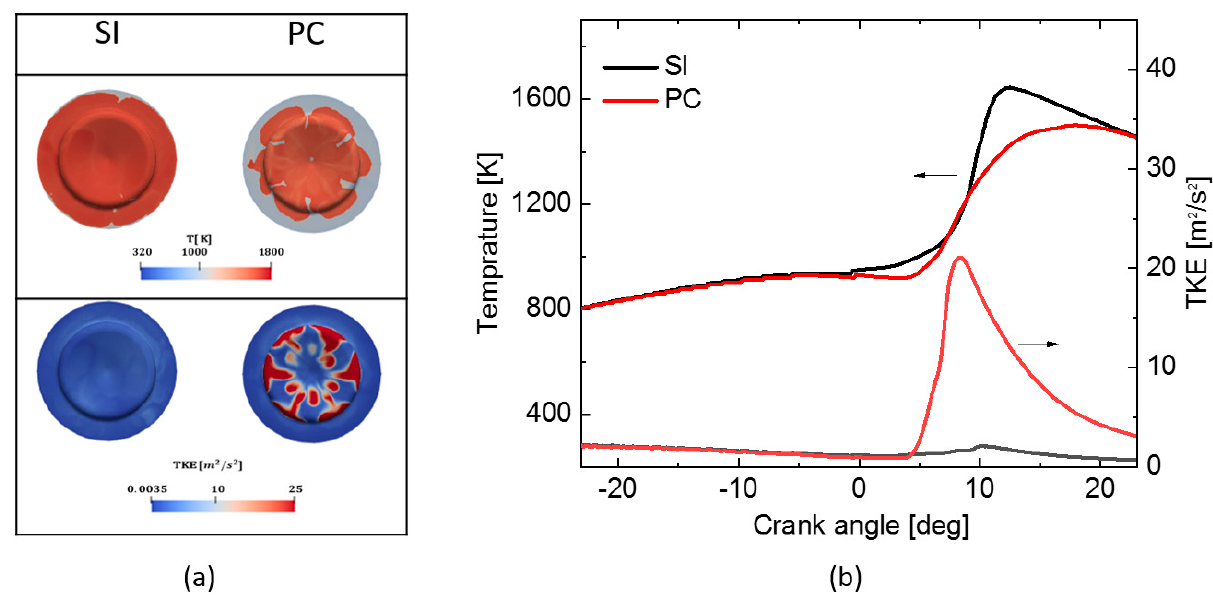
Figure 22. Comparison of the predicted piston ( a ) 3D distribution of temperature and TKE at 12 CAD, ( b ) near wall temperature and TKE for SI (CR = 14.5 and ST = − 8 ◦ ) and passive PC (CR = 14 and ST = − 3 ◦ ) modes using λ = 4.